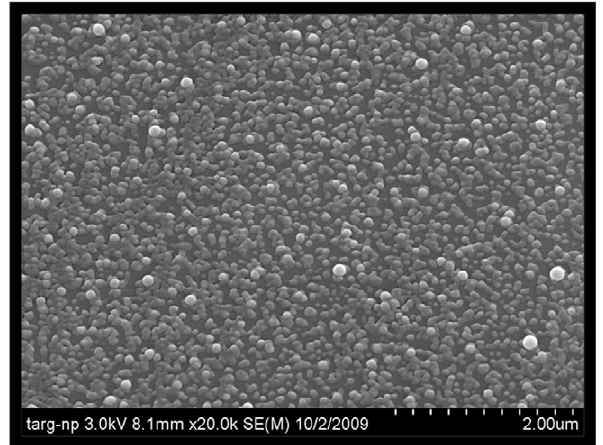
Figure 2. SEM of nanoparticles. The nanometer size of the nanocarriers was confirmed with a scanning electron micrograph of the nanoparticles. The scale bar is 2 m m.